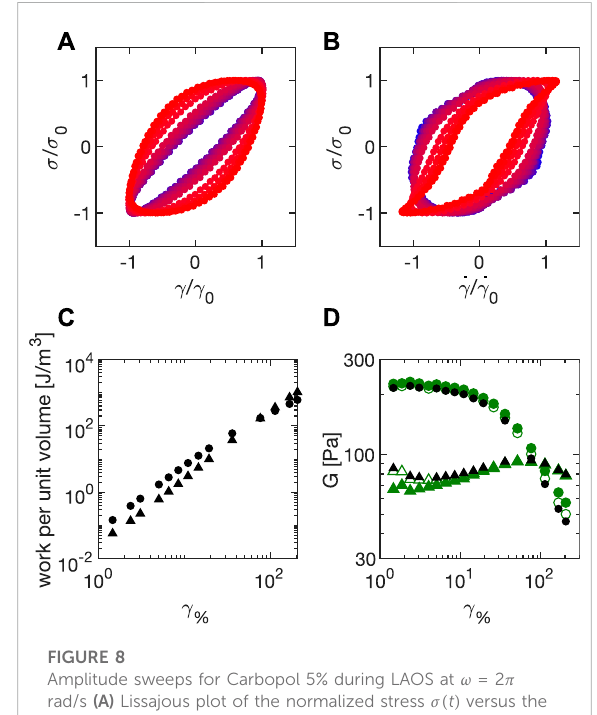
FIGURE 8 Amplitude sweeps for Carbopol 5% during LAOS at ω = 2 π rad/s (A) Lissajous plot of the normalized stress σ ( t ) versus the normalized strain γ ( t ) . Color scale progressively goes from low stresses (blue points, σ 0 = 3.5 Pa) to large stresses (red points, σ 0 = 190 Pa). (B) Lissajous plot of the normalized stress the normalized strain rate _ γ ( t ) . Color scale is the same as in (A) . (C) Dissipated energy per unit volume W D (triangle) and elastic energy per unit volume W E (circles) as obtained from the Lissajous plots in (A) and (B) , respectively. (D) Storage (black circles) and loss (black triangles) moduli as obtained from the closed integral of the Lissajous plots. In green, we report the results obtained with a sinusoidal fi t of γ ( t ) : full green symbols represent data corrected with inertia and sliding friction corrections and were already shown in Figure 7; both black and empty green symbols represent uncorrected data obtained from Lissajous integrals and from the fi t,